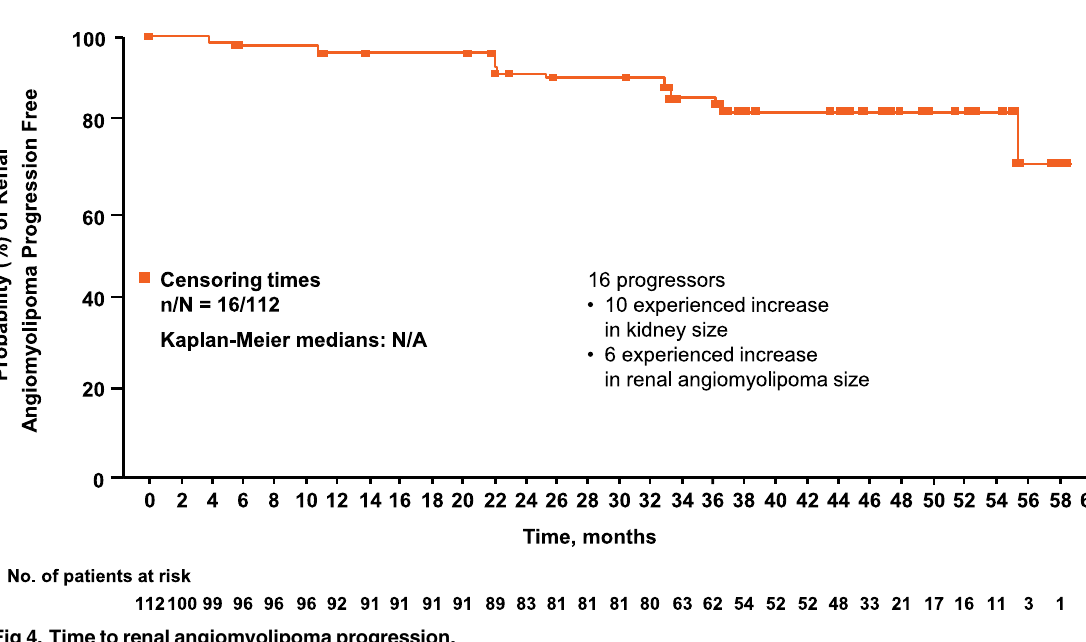
population (80.4%, 90/112). Only 2 of the 65 patients who achieved a confirmed angiomyoli- poma response had disease progression based on their lowest angiomyolipoma volume during the course of the trial. The duration from the first response to angiomyolipoma progression or the last available radiologic assessment ranged from 3.0 to 55.5 months.